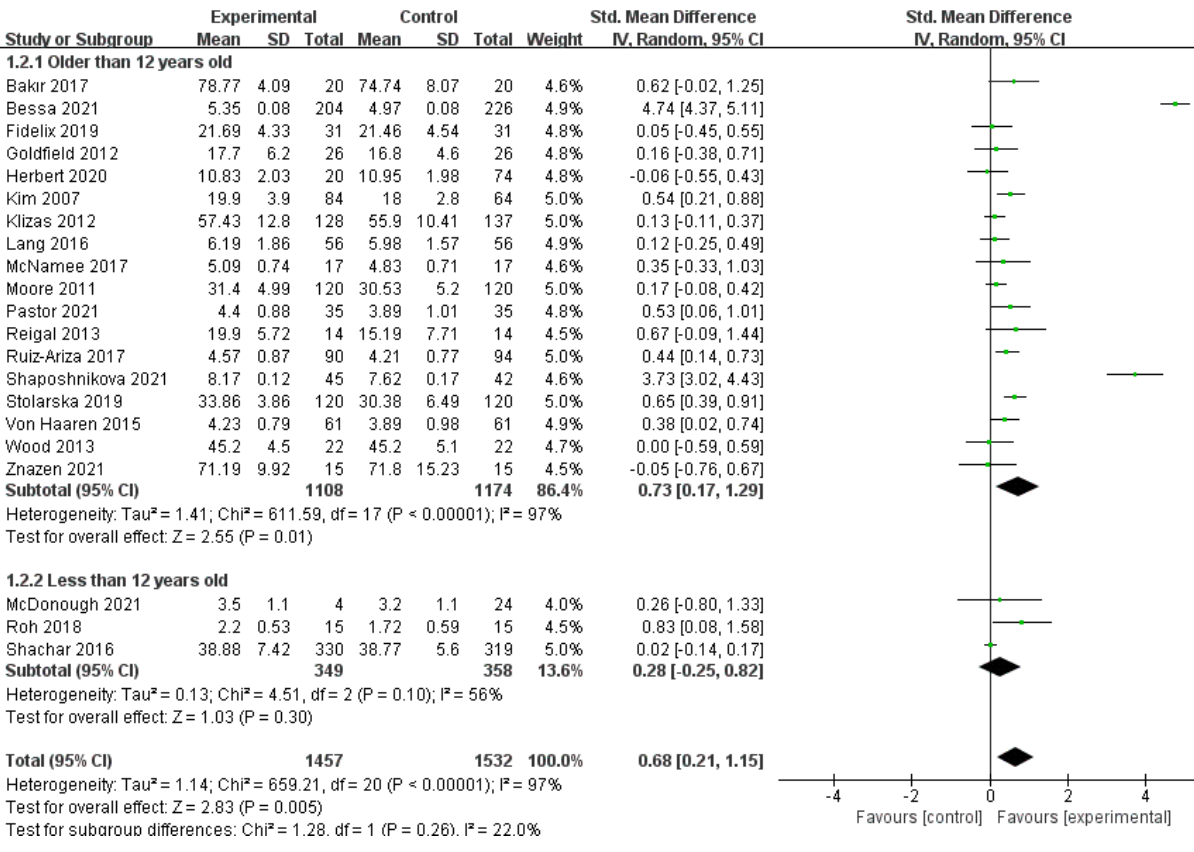
Figure 3. Age subgroup of the association between PA and positive emotions in children and adolescents [30 – 37,39 – 43,45 – 47,49 – 53]